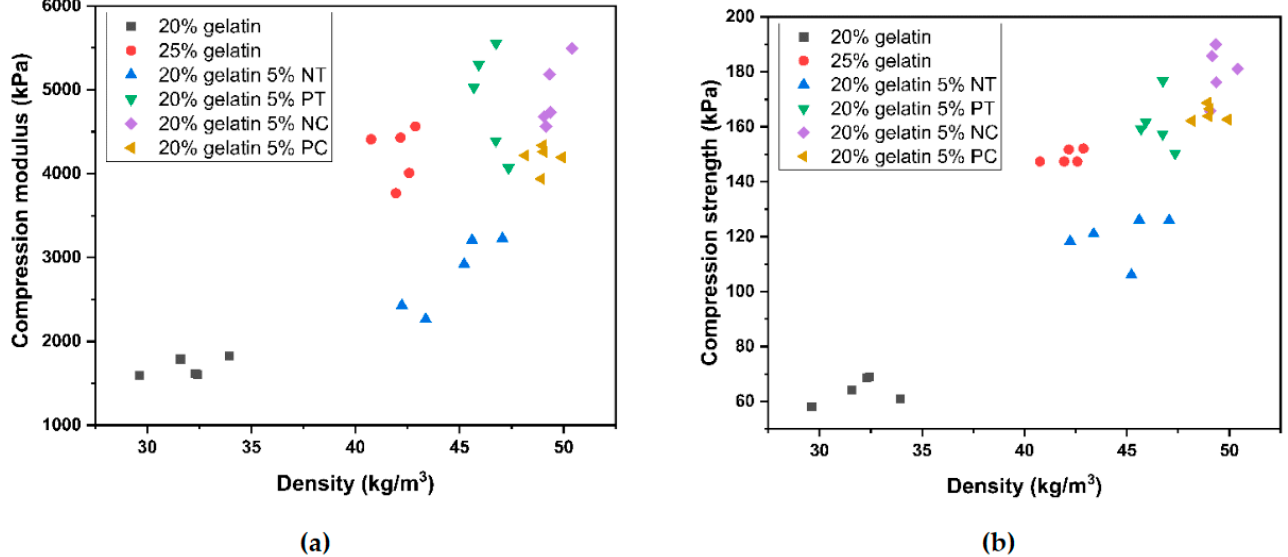
Figure 8. Scatter plot of ( a ) compressive strength and density and ( b ) compressive modulus (23 °C, 50% RH) for the gelatin and gelatin–starch foams produced by mechanical foaming. 50% RH) for the gelatin and gelatin–starch foams produced by mechanical